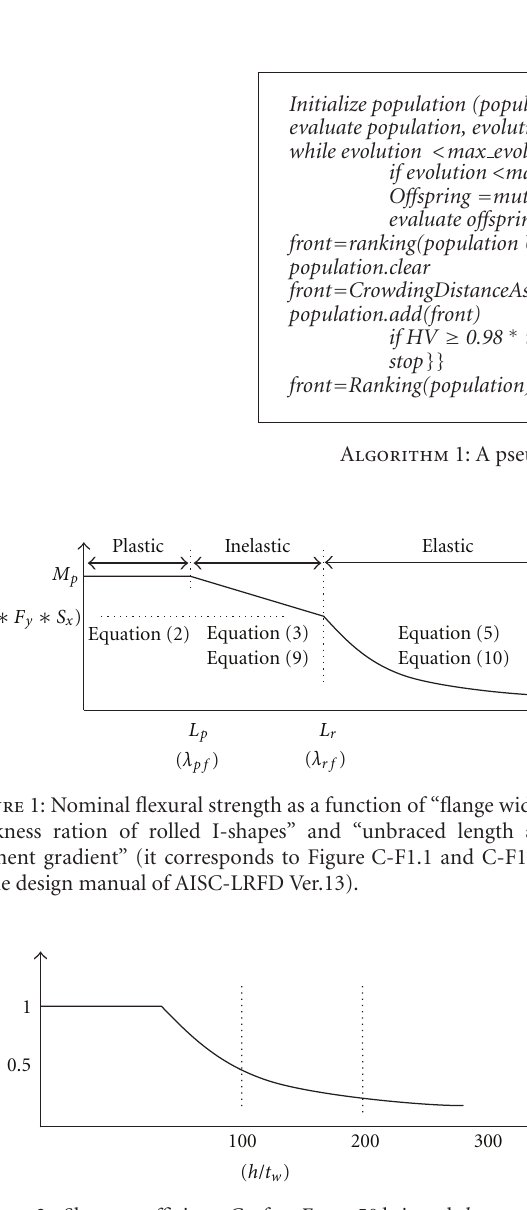
Figure 2: Shear coe ffi cient C v for F y = 50 ksi and k v = 5 . 0 (it corresponds to Figure C-G2.1 in the design manual of AISC-